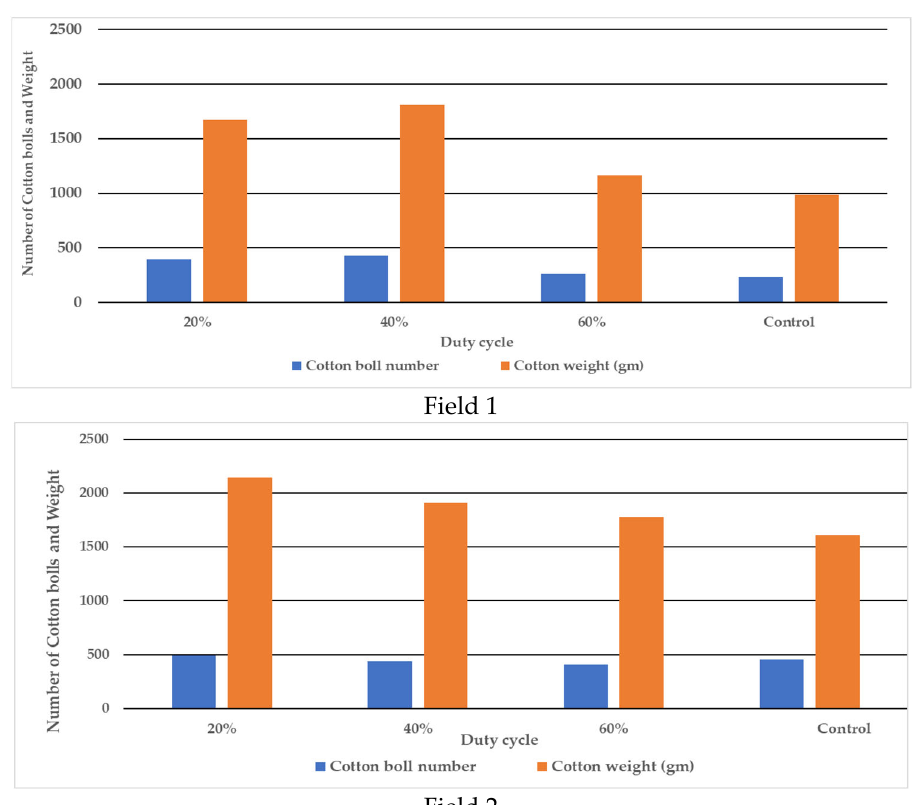
Figure 11. Average cotton boll and weight data for both fields across treatments.